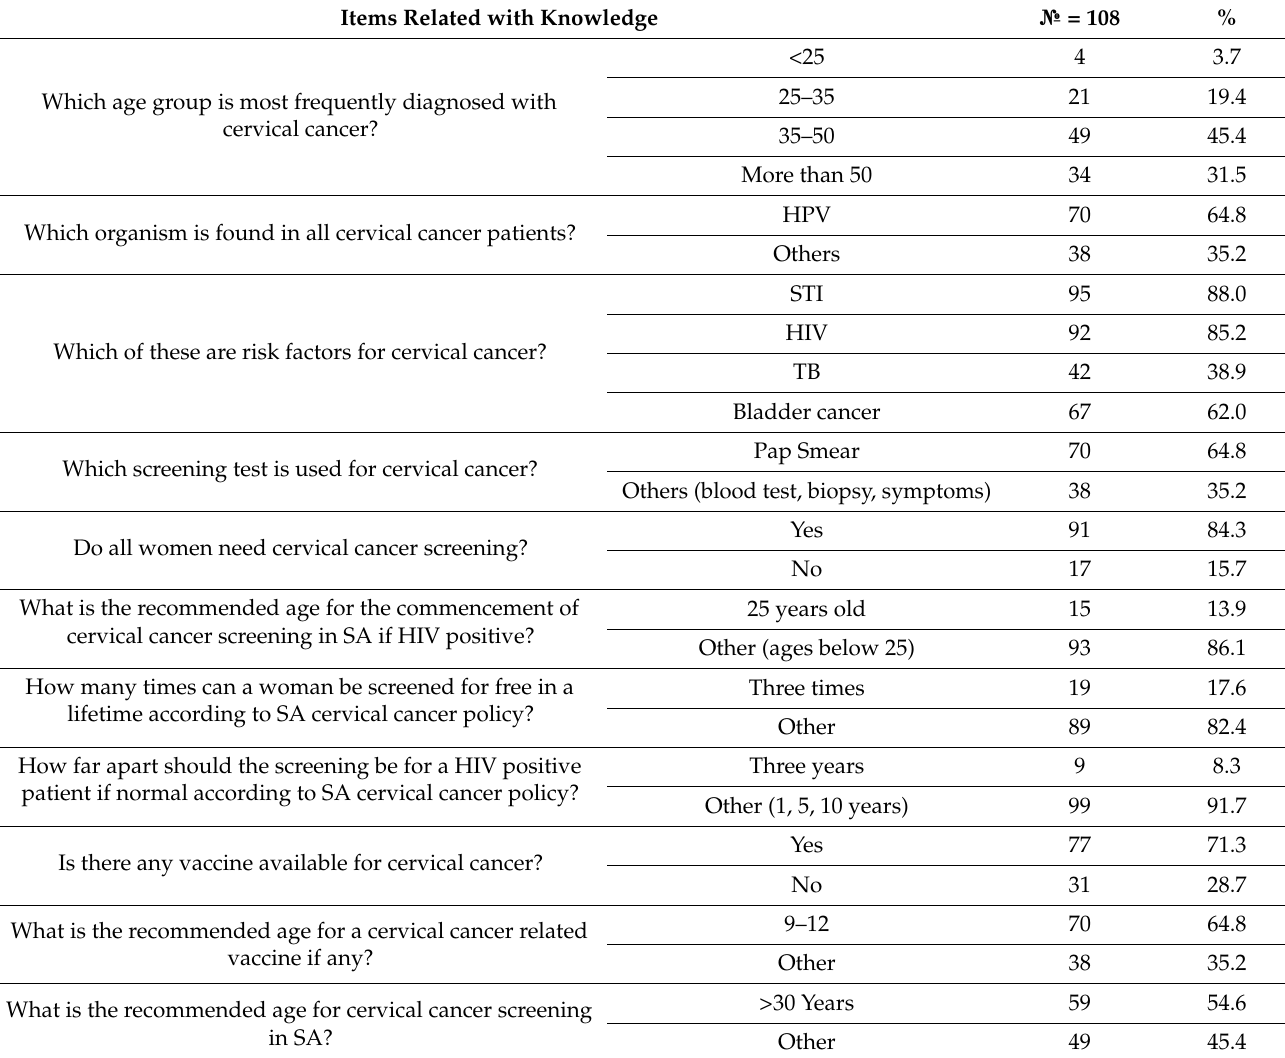
Table 2. Cervical cancer knowledge and awareness among